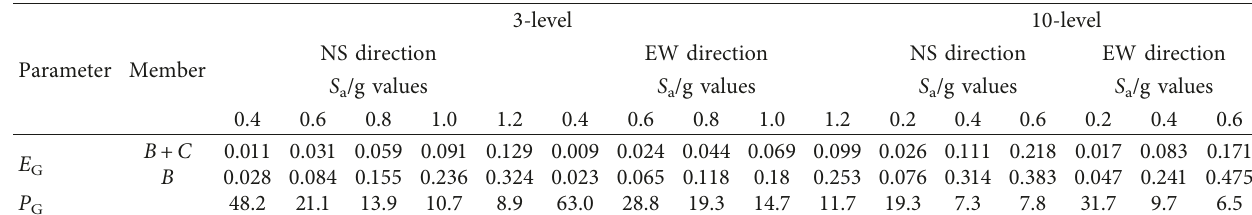
Table 8: Mean values of E G for the 3- and 10-level